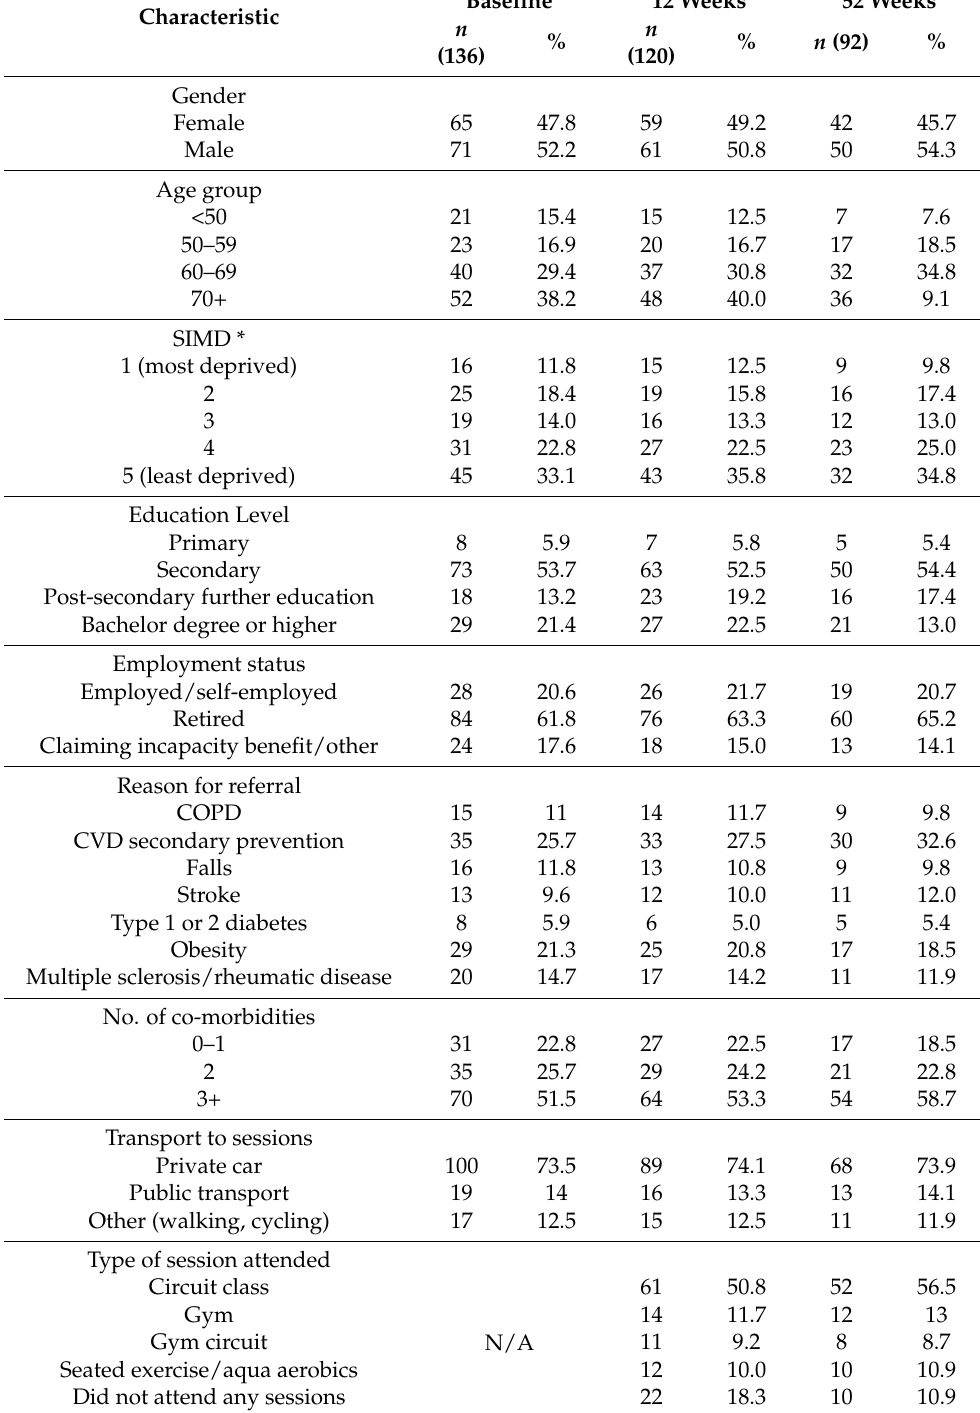
Table 2. Participant characteristics at baseline, 12 and 52